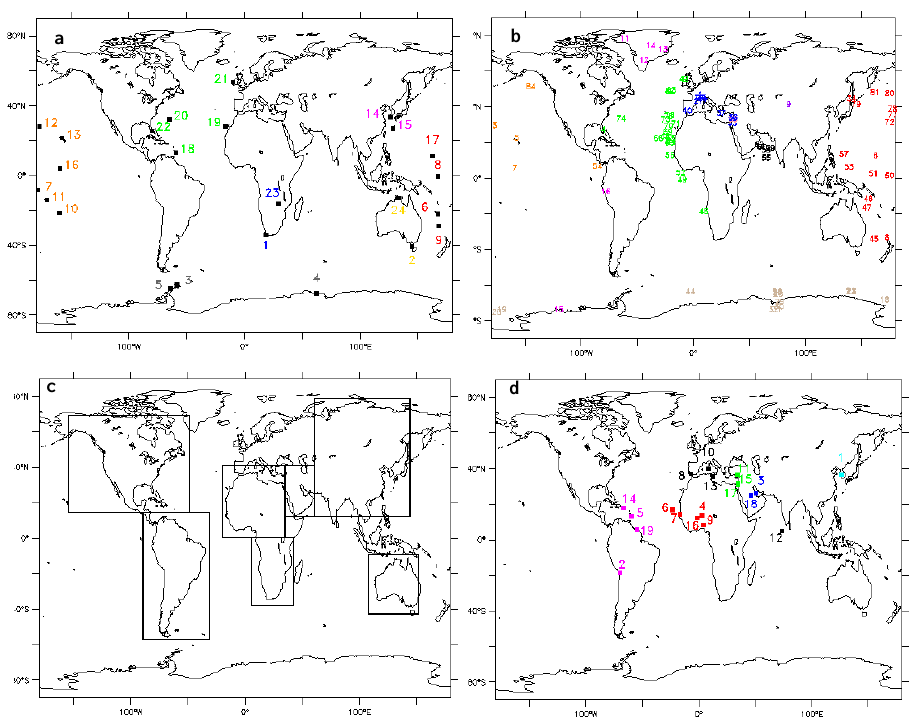
Fig. 3. Stations used for the model evaluation: (a) for dust concentrations, (b) for dust deposition. The names of the stations that correspond to each number are given in the supplement. (c) The black boxes denote the areas for the calculation of the regional emissions in Table 6. (d) Location of the 19 AERONET stations used for the model evaluation of